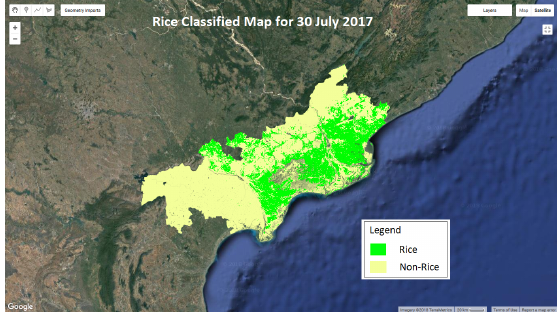
Figure 8. Rice Classified Map for 30 July 2017